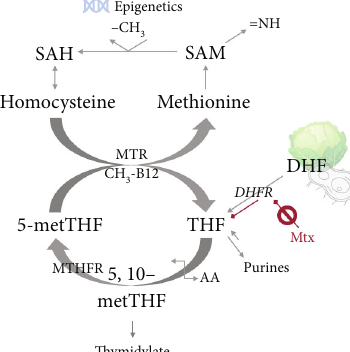
Figure 3: Pathways of folate metabolism and the interrelationships of folate-dependent reactions. Dihydrofolate (DHF) from nutritional sources and the gut micro fl ora is enzymatically reduced engaging dihydrofolate reductase (DHFR) to biologically active tetrahydrofolate (THF), a process that is competitively blocked by the folate analogue methotrexate (Mtx). This has implications for cell proliferation, division, and survival. Folate metabolism branches out into anabolic pathways including synthesis of amino acids (AA) and amines (=NH) as well as purines and thymidylate for DNA production. Importantly, folate in the form of 5-methyl tetrahydrofolate (5-metTHF) serves as a methyl-group (CH ) donor in the detoxi fi cation of proatherogenic 3 homocysteine to the AA methionine. SAM is the universal CH 3 donor in histone- and DNA-methylation. This function gives folate powerful mediating properties at an epigenetic level with a potential role in thymic CD4 + n T expansion. Abbreviations: reg MTR: methionine synthase requiring the co-factor vitamin B12 (cobalamin) as a methyl transfer vehicle (methyl cobalamin, CH - 3 B12); MTHFR: 5,10-methylenetetrahydrofolate reductase (requiring the co-factor NADPH, not shown); THF: tetrahydrofolate. Methionine cycle metabolites: SAH: S-adenosylhomocysteine; SAM: S-adenosylmethionine; =NH: